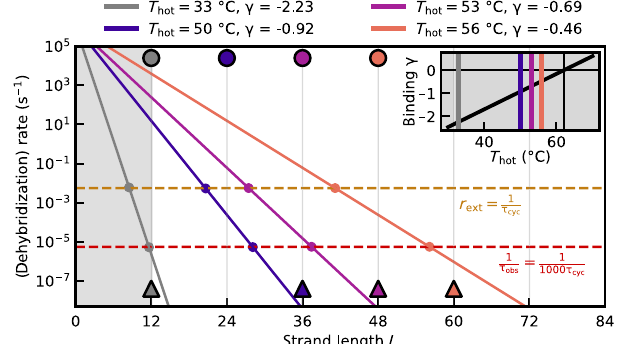
FIG. 9. Temperature dependence of the emerging length scales in the effective theory. Solid lines: dehybridization rate r off ¼ r e γ ð T hot Þ L for various values of T . The inset shows the linear 0 hot function γ ð T Þ , Eq. (18), with T c ¼ 62 °C and ξ ¼ 13 K. Hori- and the zontal dashed lines denote the effective extension rate τ − 1 cyc inverse observation time τ − 1 . As in Fig. 3(a), the competition of obs timescales determines the scales L (cid:1) and L † as the intersection between the solid and dashed lines. They are mapped to the observable length scales L (circles) and L (triangles) by min max 12 . By ceiling the intersection point to the next multiple of L bb ¼ approaching T c , the binding energy and thus the slope become smaller in magnitude, and the intersection points move to larger